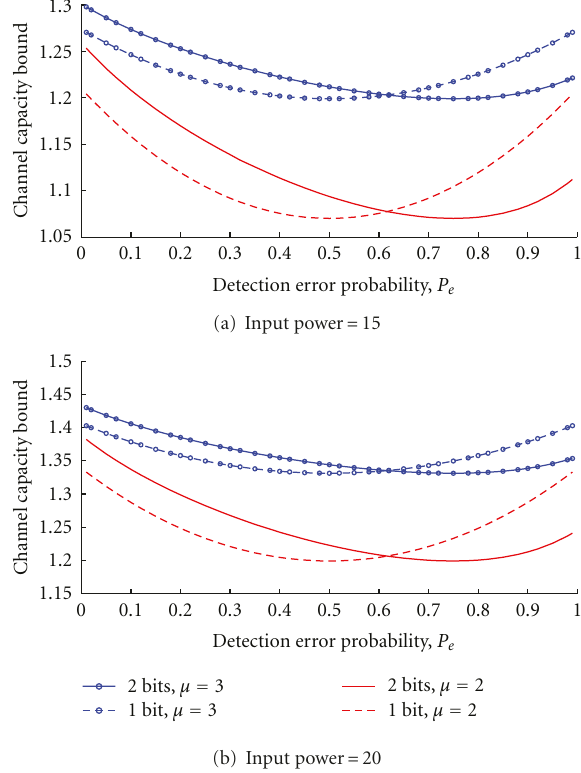
Figure 9: Channel capacity lower bound versus detection error probability. Quantization region detection model: